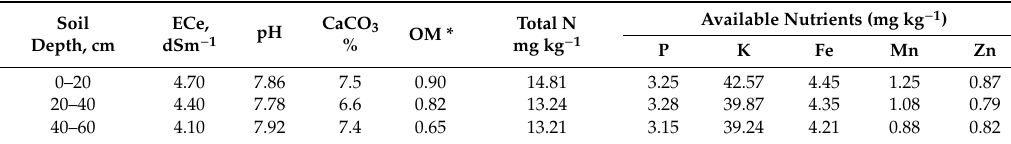
Table 2. Some chemical properties of the experimental soil.